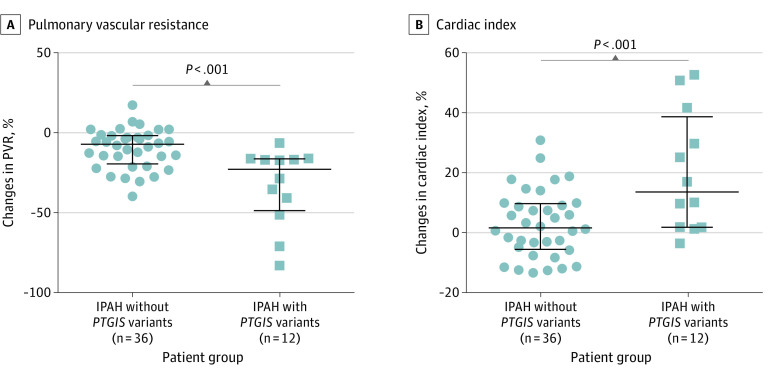
Comparison of Acute Hemodynamic Responses to Aerosolized Iloprost in Patients With Idiopathic Pulmonary Arterial Hypertension (IPAH) With or Without Prostacyclin Synthase (PTGIS) Gene VariantsIloprost inhalation induced more significant decrease of pulmonary vascular resistance (PVR) and increase of cardiac index in patients with variants in PTGIS. The data were analyzed by the linear regression model.